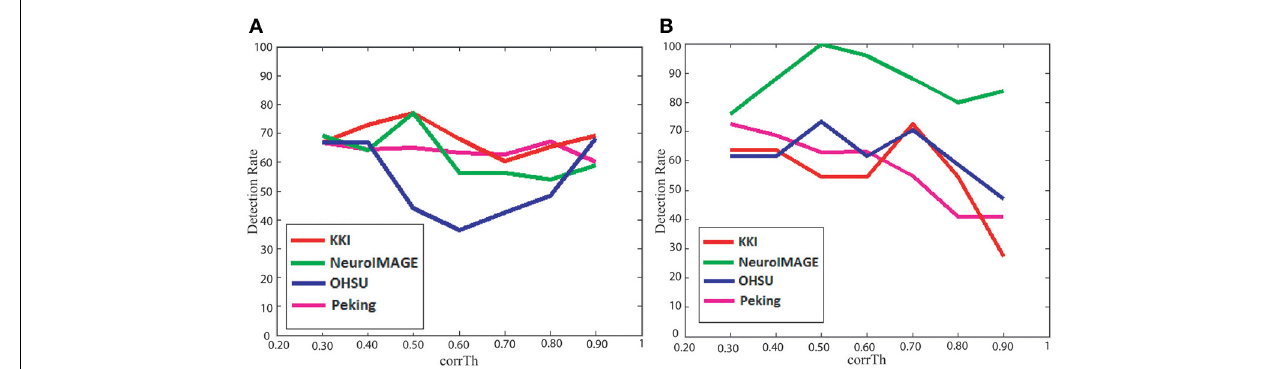
FIGURE 2 | Figure plots corrTh vs. detection rates of our method on the (A) training data sets and (B) test data